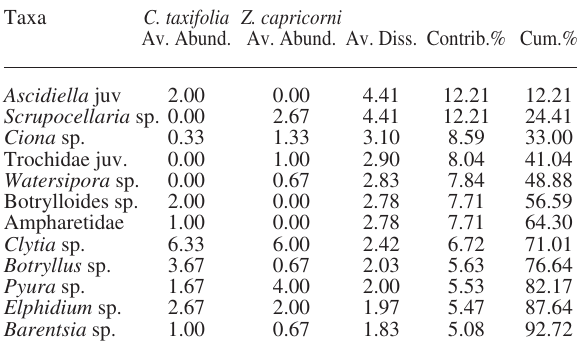
Table 3. – SIMPER analysis of presence/ absence data showing the contribution (% cumulative=90%) of each taxa to average dis- similarities (Jaccard Index) between Caulerpa taxifolia and Zostera capricorni habitats.